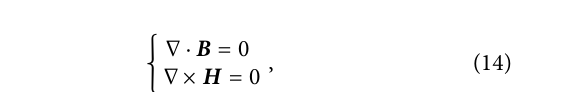
FIGURE 2 | Interface problems of permanent magnetic fi eld (A) and uniform magnetic fi eld (B)